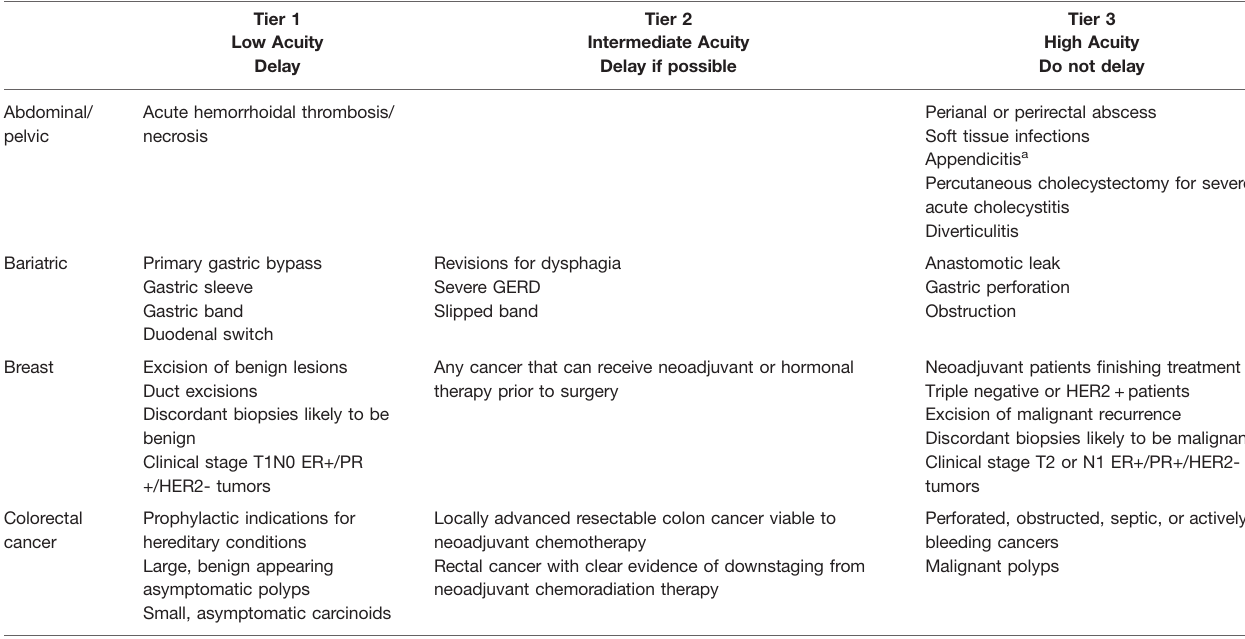
Table 2 and 5 summarizes current neurosurgical guidelines regarding the timing of surgery for COVID-19 patients.